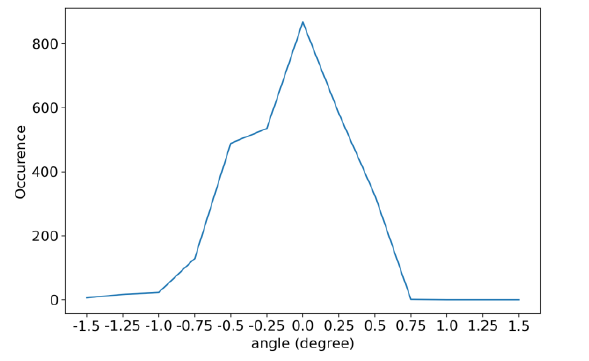
Figure 11. Distribution of heading angles leading to the highest consensus sets.